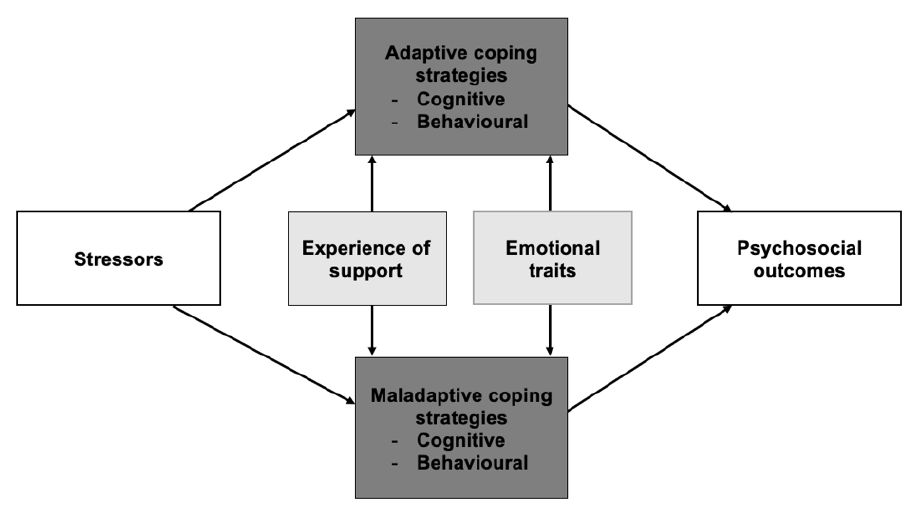
Figure 1. Model of stressors, coping strategies, psychosocial outcomes, and moderating factors.